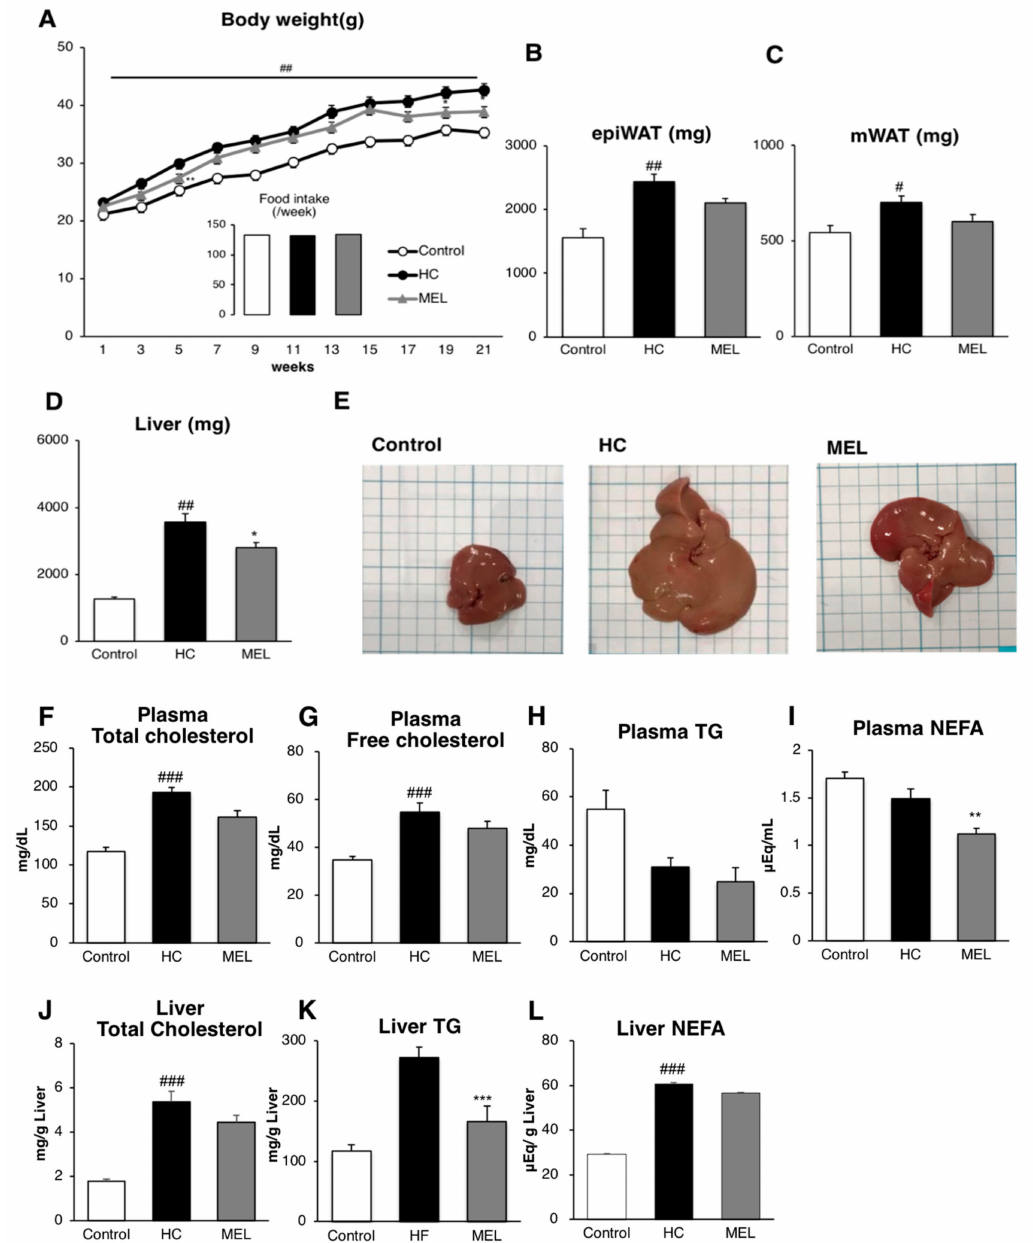
Figure 1. Melon GliSODin ® prevents diet-induced non-alcoholic steatohepatitis. Control diet (Control), high-fat and high-cholesterol diet (HC), and high-fat, high-cholesterol + 1% Melon GliSODin ® diet (MEL). ( A ) Evolution of body weight gain and food intake with di ff erent diets. ( B ) Weight of epidydimal whiteadiposetissue(WAT).( C )WeightofmesentericWAT.( D )Weightoftheliver. ( E )Liverphotographs of the control, HC, and MEL groups. ( F ) Plasma lipid parameters, ( G ) total cholesterol, ( H ) triglycerides (TG), and ( I ) non-esterified fatty acid (NEFA). ( J ) Liver total cholesterol, ( K ) TG, and ( L ) NEFA. Data are shown as mean ± SEM values. n = 7 mice per group. Statistical analysis was performed using one-way ANOVA followed by the Bonferroni’s post hoc test. # / * p < 0.05; ## / ** p < 0.01, ### / *** p < 0.001 versus mice fed HC diet. ( # Significant di ff erences HC versus Control, *Significant di ff erences HC versus